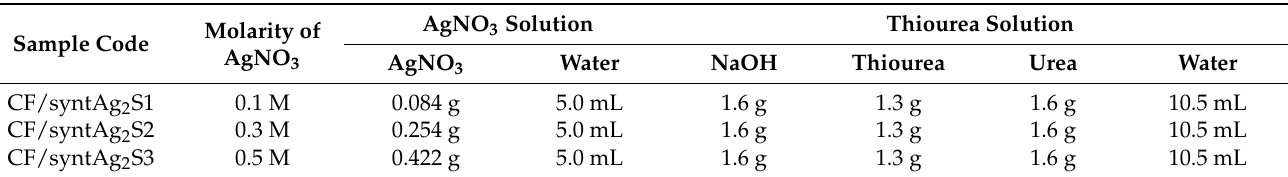
Table 3. Sample code and sample composition to synthesize samples CF/syntAg 2